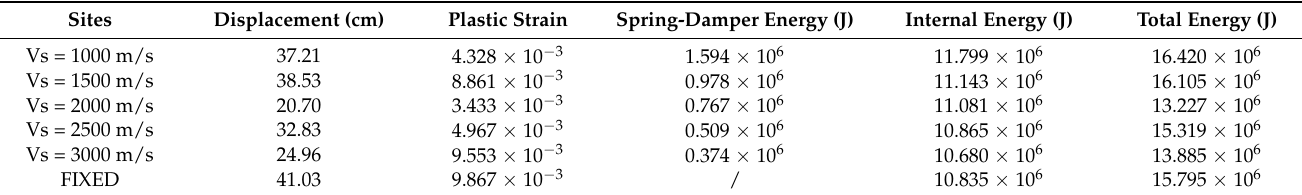
Figure 7. Max plastic strain time-histories of steel plate. Table 4. The peak displacement, plastic strain, spring-damper energy, internal energy, and total